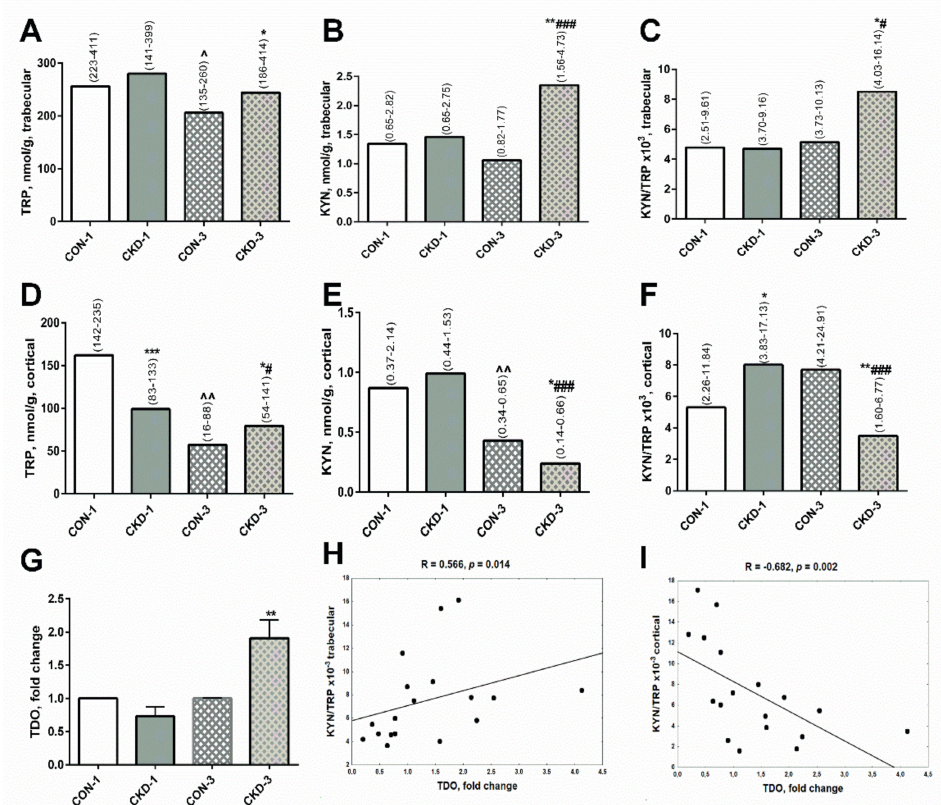
Figure 1. Kynurenine pathway in bone of young rats with chronic kidney disease (CKD). TRP ( A,D ), KYN ( B,E ) concentrations and KYN/TRP ratio ( C,F ) in bone homogenates, TDO gene ex- pression in bone ( G ), and the association between TDO gene expression and KYN/TRP ratio in bone homogenates ( H,I ). Data are median (full range) or fold change ± s.e.m; * p < 0.05, ** p < 0.01, *** p < 0.001 controls versus appropriate CKD group; ˆ p < 0.05, ˆˆ p < 0.01 CON-1 versus CON- 3; # p < 0.05, ### p < 0.001 CKD-1 versus CKD-3; Abbreviations: CKD = chronic kidney